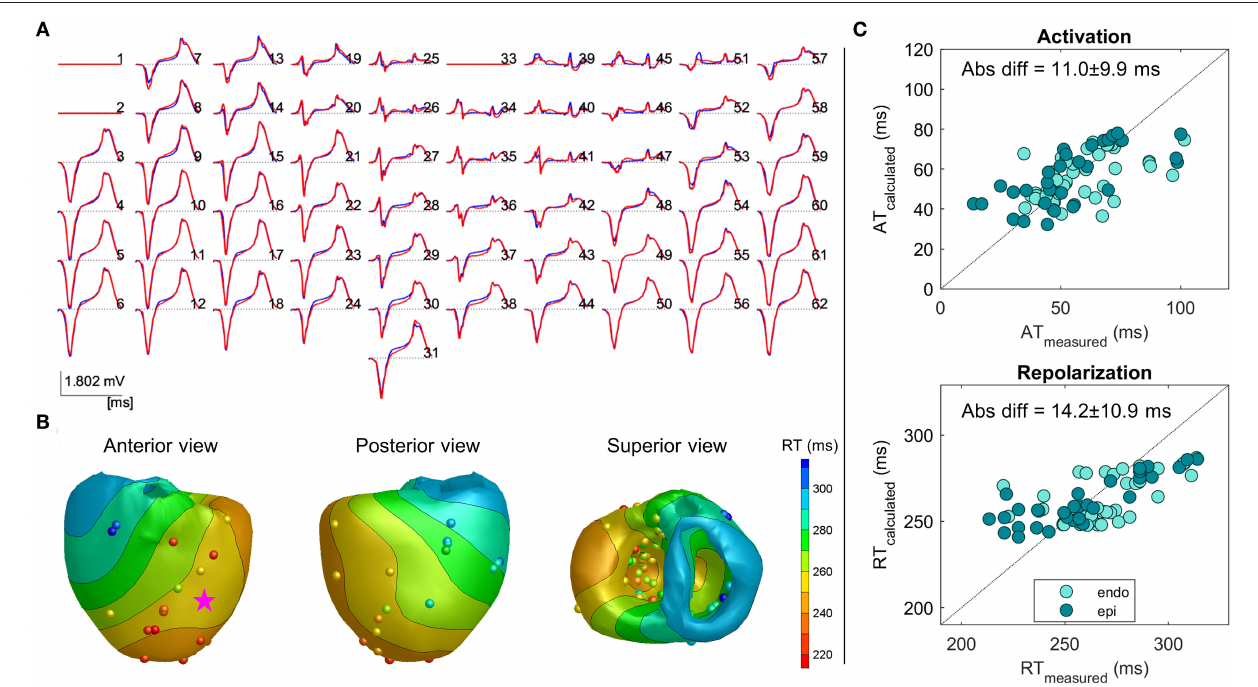
FIGURE 3 | Example 2: Inverse reconstruction of heart 4, left ventricular (LV) paced beat (pink star indicating pacing location). The configuration is similar to that mentioned in Figure 2 .